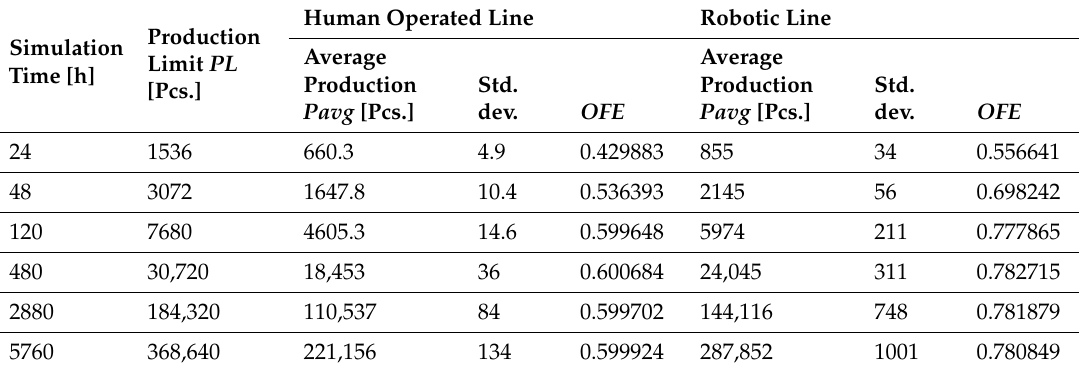
Table 3. Results of simulation experiments with human and robot failures—average production value Pavg for 20 simulation runs with a confidence level at